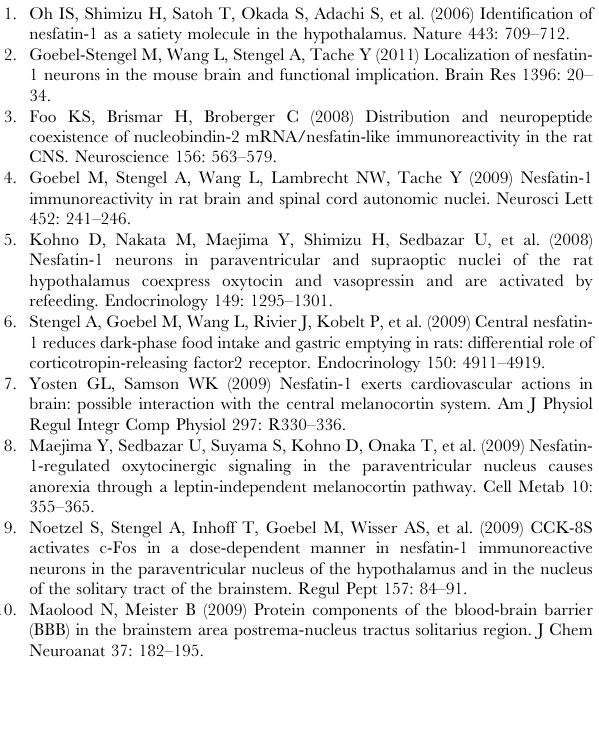
Figure 7. Nesfatin-1 decreased excitability of GI-neurons in DVC. Current-clamp recordings from DVC neurons in slice preparation. (A) Identification of GI neurons in the DVC. Representative raw traces of spontaneous action potentials were recorded before, during, and after application of glucose (5 mM), (B) Changes in firing rate after application of glucose. (C-D) Changes in firing rate after application of nesfatin-1 (10 nM). (E) Hyperpolarizing responses to 5 mM glucose and 10 nM nesfatin-1 (horizontal bar). (F) Mean response to bath application of 5